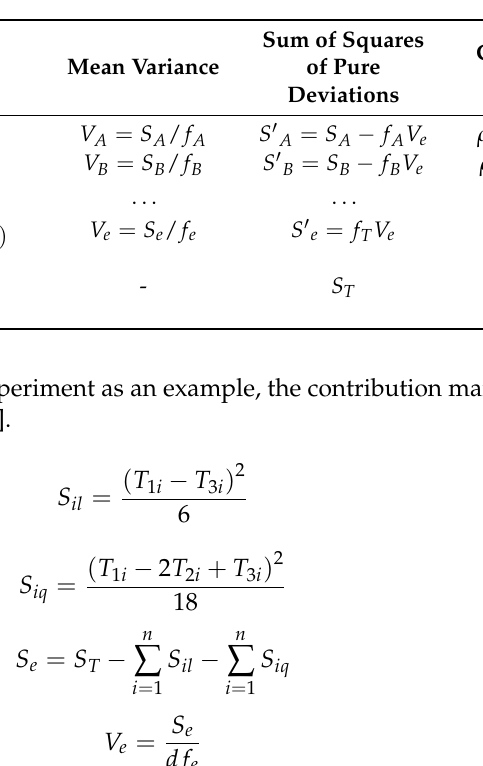
Table 1. Calculation and analysis of the contribution rate of multiple design parameters.